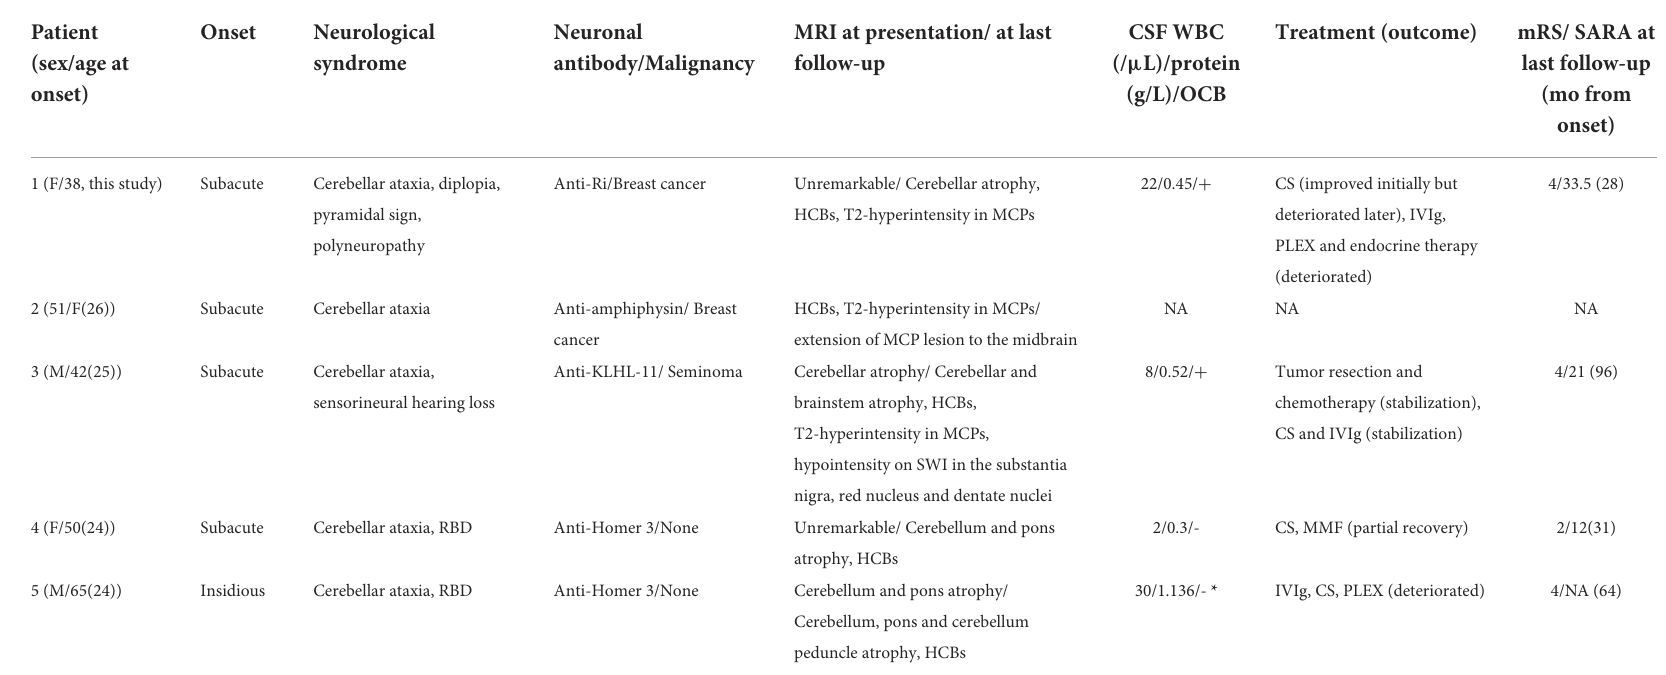
TABLE 1 A summary of patients with autoimmune cerebellar ataxia showing the